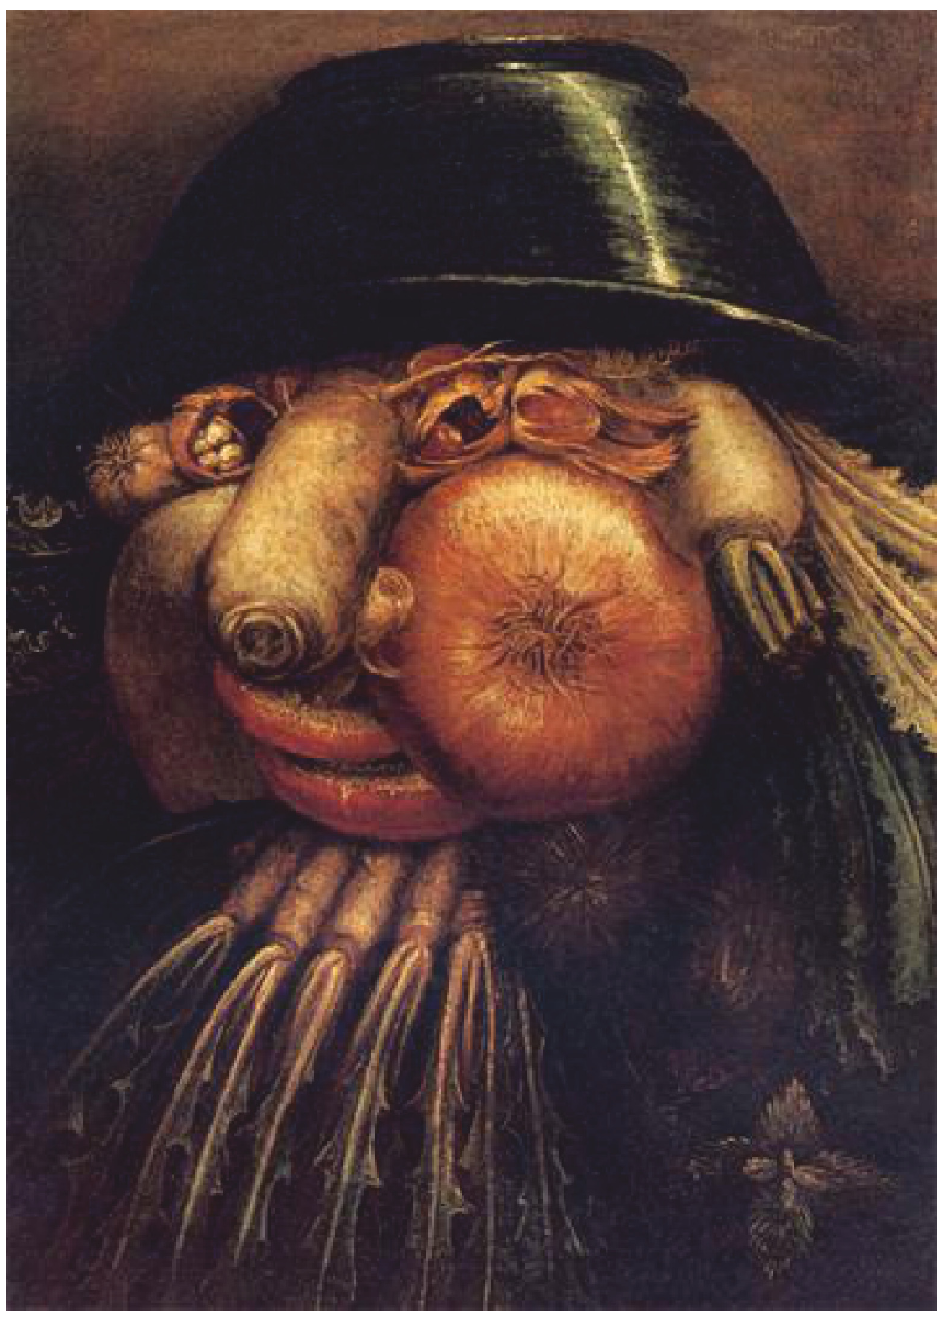
Fig 1. An example of portraits by Giuseppe Arcimboldo. “ The Gardner ” by Guiseppe Arcimboldo (1526 – 1593), an Italian painter best known for creating fascinating (often grotesque and allegoric) imaginative portraits composed entirely of fruits, vegetables, plants, tree roots, flowers, and even books and human bodies (http://www.wikiart.org/en/giuseppe-arcimboldo/the-gardner; public domain).